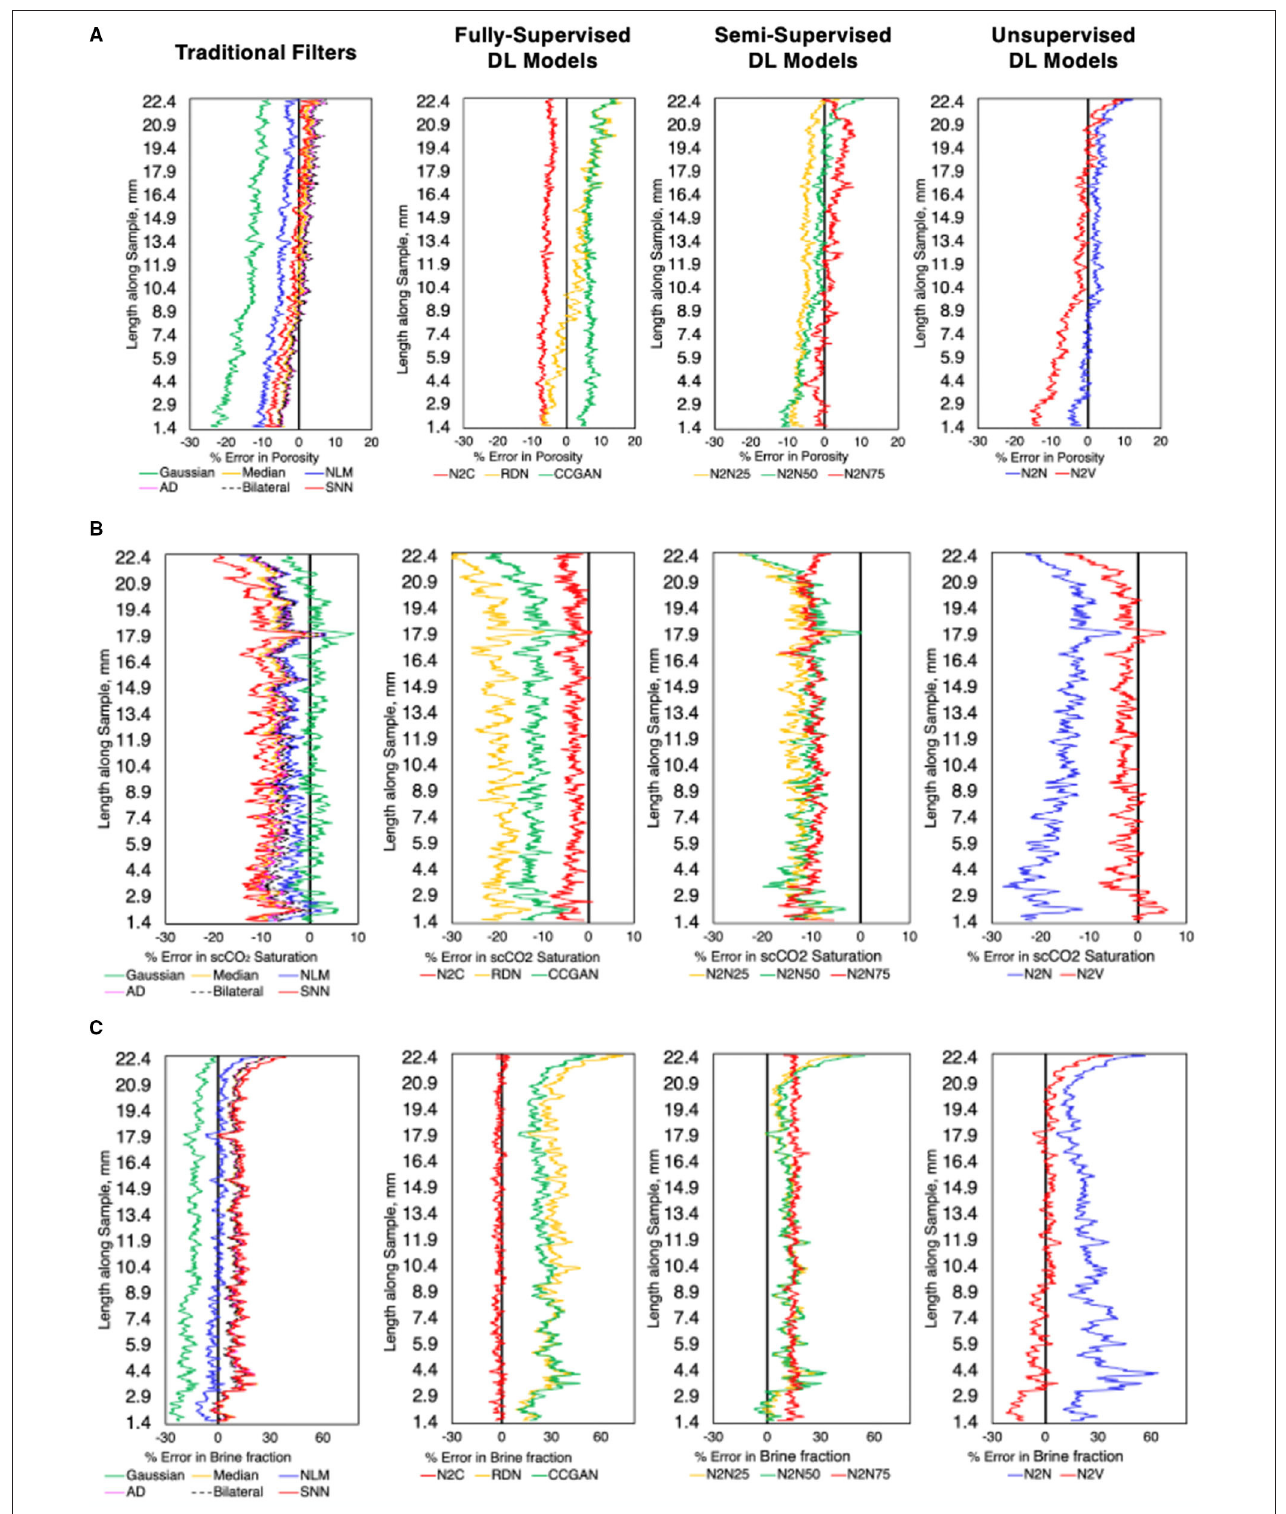
FIGURE 7 | (A) Porosity, (B) scCO 2 saturation, and (C) brine phase fraction percent error (relative to HQ) along the length of the core for the different denoising methods.